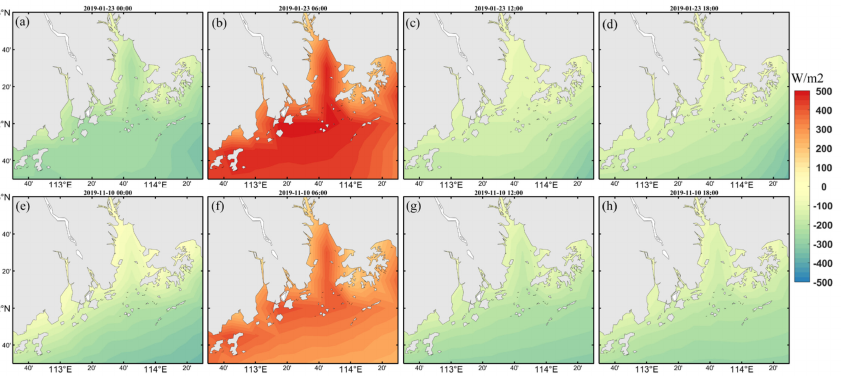
Figure 10. Six snapshots of hourly air-sea net heat fluxes for 23 January ( a – d ) and 10 November 2019 ( e – h ). Positive values represent seawater net heat gain. The subtitles in subplots ( a – h ) indicate the corresponding observation time (unit: